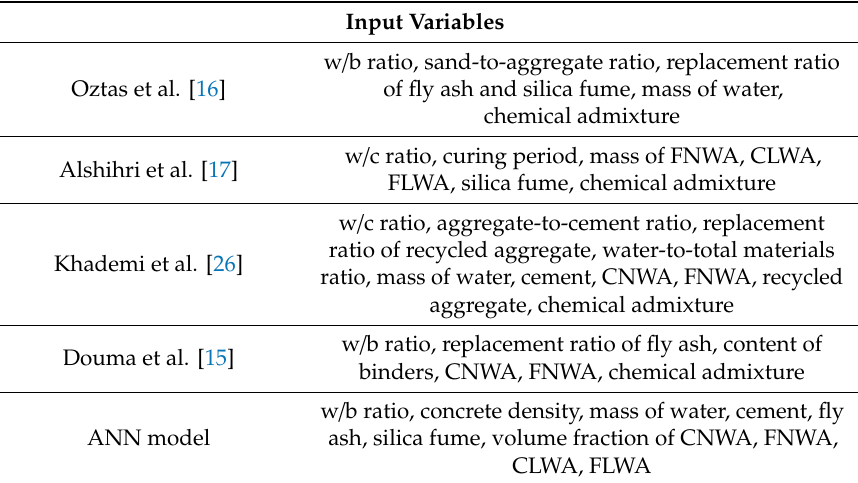
Table 3. Input variables for the ANN